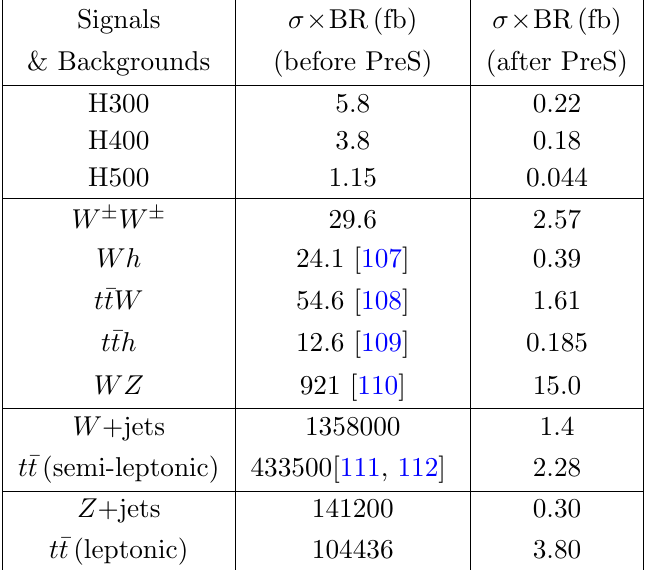
Table 4 . (cid:27) (cid:2) Br for the signal process (with three benchmarks) and for the major backgrounds in the SS2L decay channel before and after pre-selections (PreS), where the last two categories denote backgrounds with fake leptons and charge-misidenti(cid:12)cations. For each background (with a cited reference), the cross section includes the QCD corrections ( K -factor), while the rest of cross sections are computed by MadGraph5 at the leading